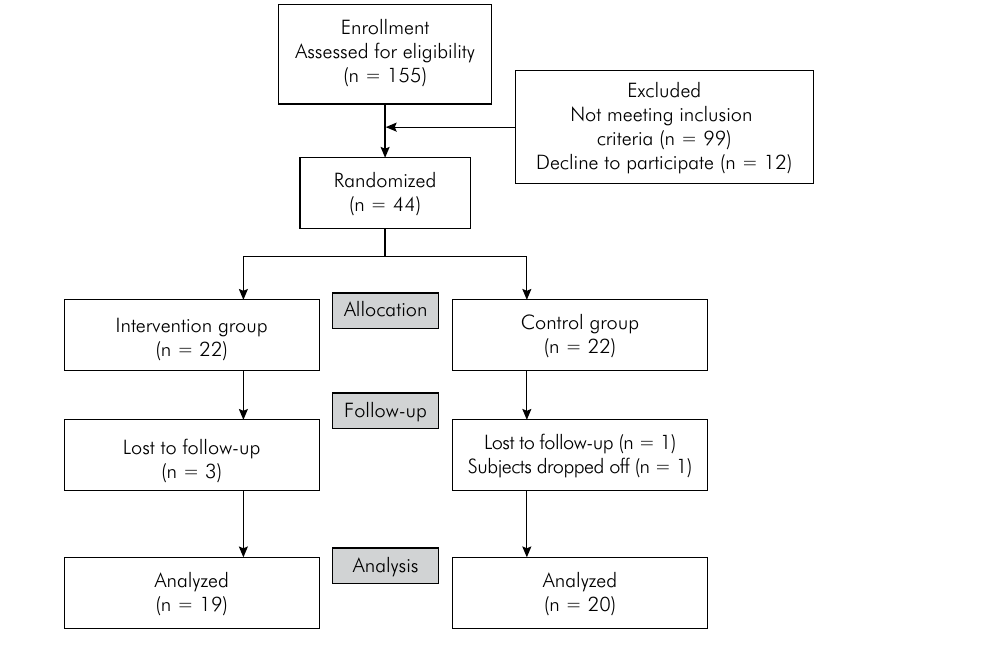
Figure 1. Flow diagram of subject inclusion in the